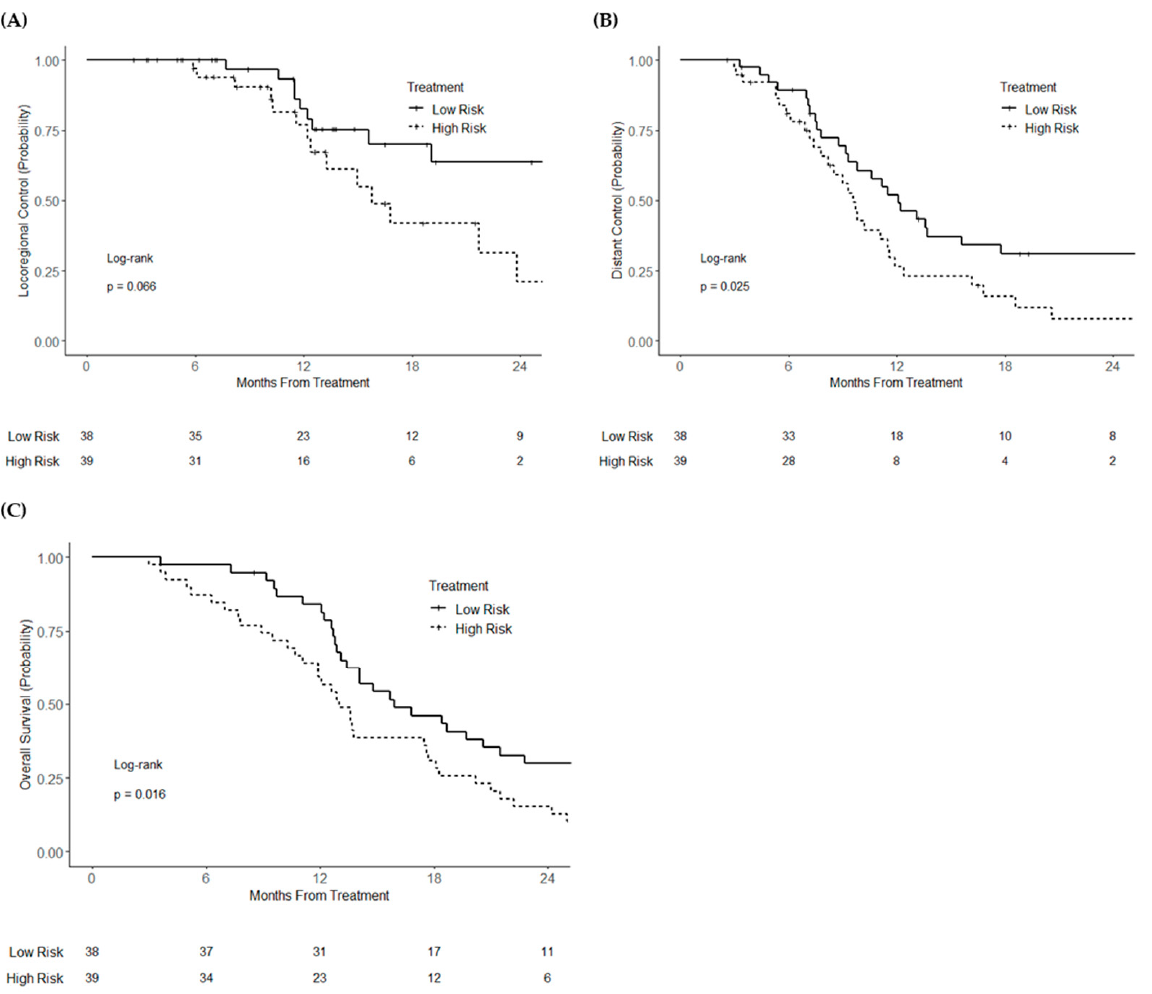
Figure 3. Kaplan–Meier curves of ( A ) locoregional control, ( B ) distant control, and ( C ) overall survival of patients with borderline resectable or locally advanced (unresectable) pancreatic cancer, stratified by risk score group.